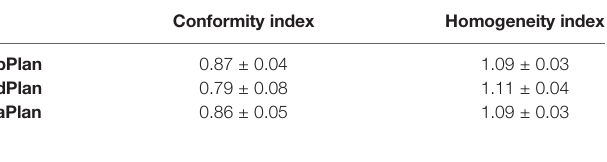
TABLE 3 | Conformity and homogeneity indices in the primary plan (pPlan), actually delivered plan (dPlan) and adapted plan (aPlan). All values given as mean ± standard deviation.